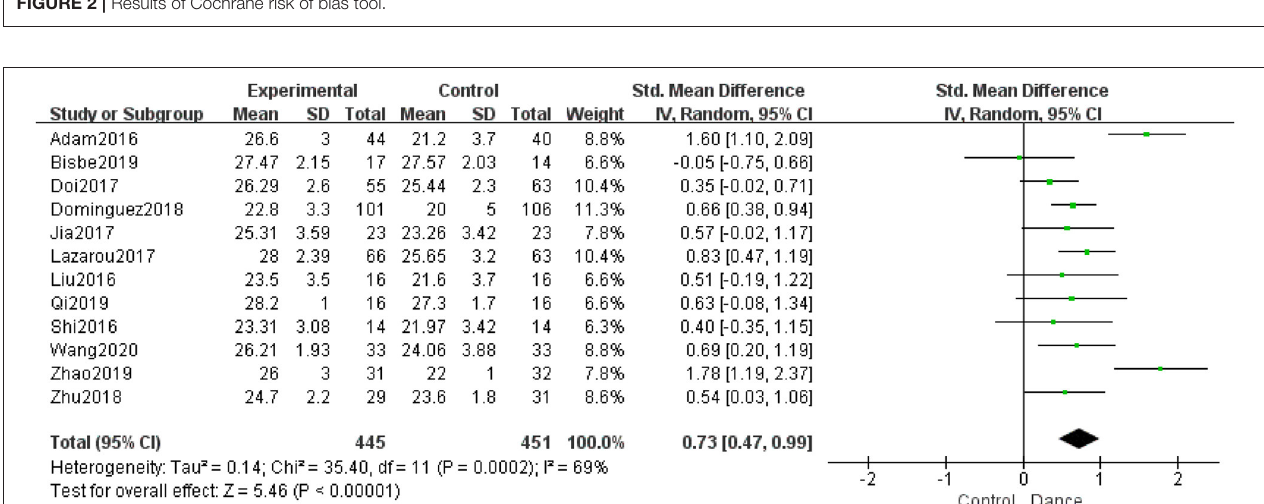
FIGURE 3 | Forest plot of global cognition results of dance group vs. control group.